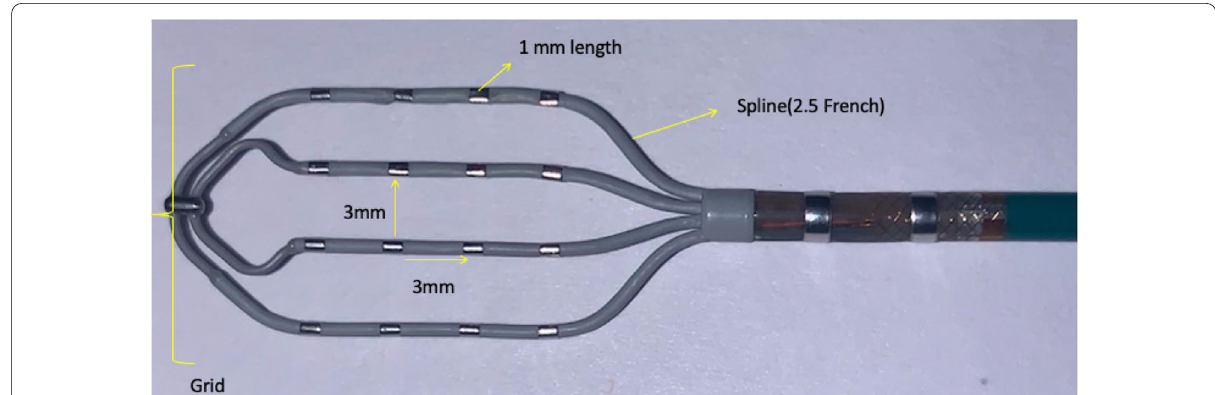
Fig. 7 The Advisor ™ HD Grid catheter is a bidirectionally steerable mapping catheter that has four splines consisting of 4 electrodes each. Inter-electrode spacing is 3 mm equally across and along the